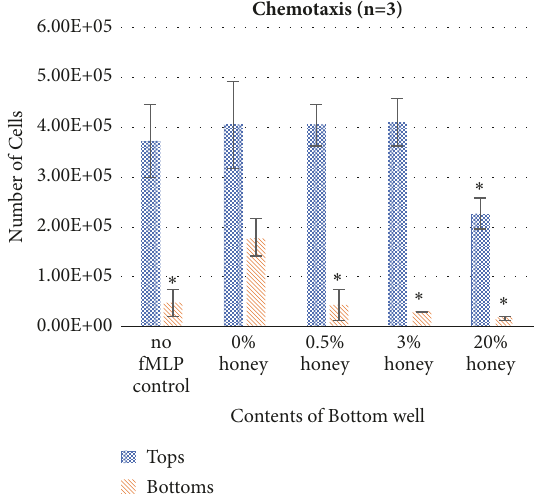
Figure 4: Chemotaxis of 500,000 dHL-60s to 50 nM fMLP in various concentrations of honey. Cell numbers in top and bottom chambers were measured using a Countess II FL automated cell counter. ∗ indicates a statistically significant difference in cell number from the 0% honey sample. 𝛼 =0.05, measured via one-way ANOVA with Holm-Sidak post